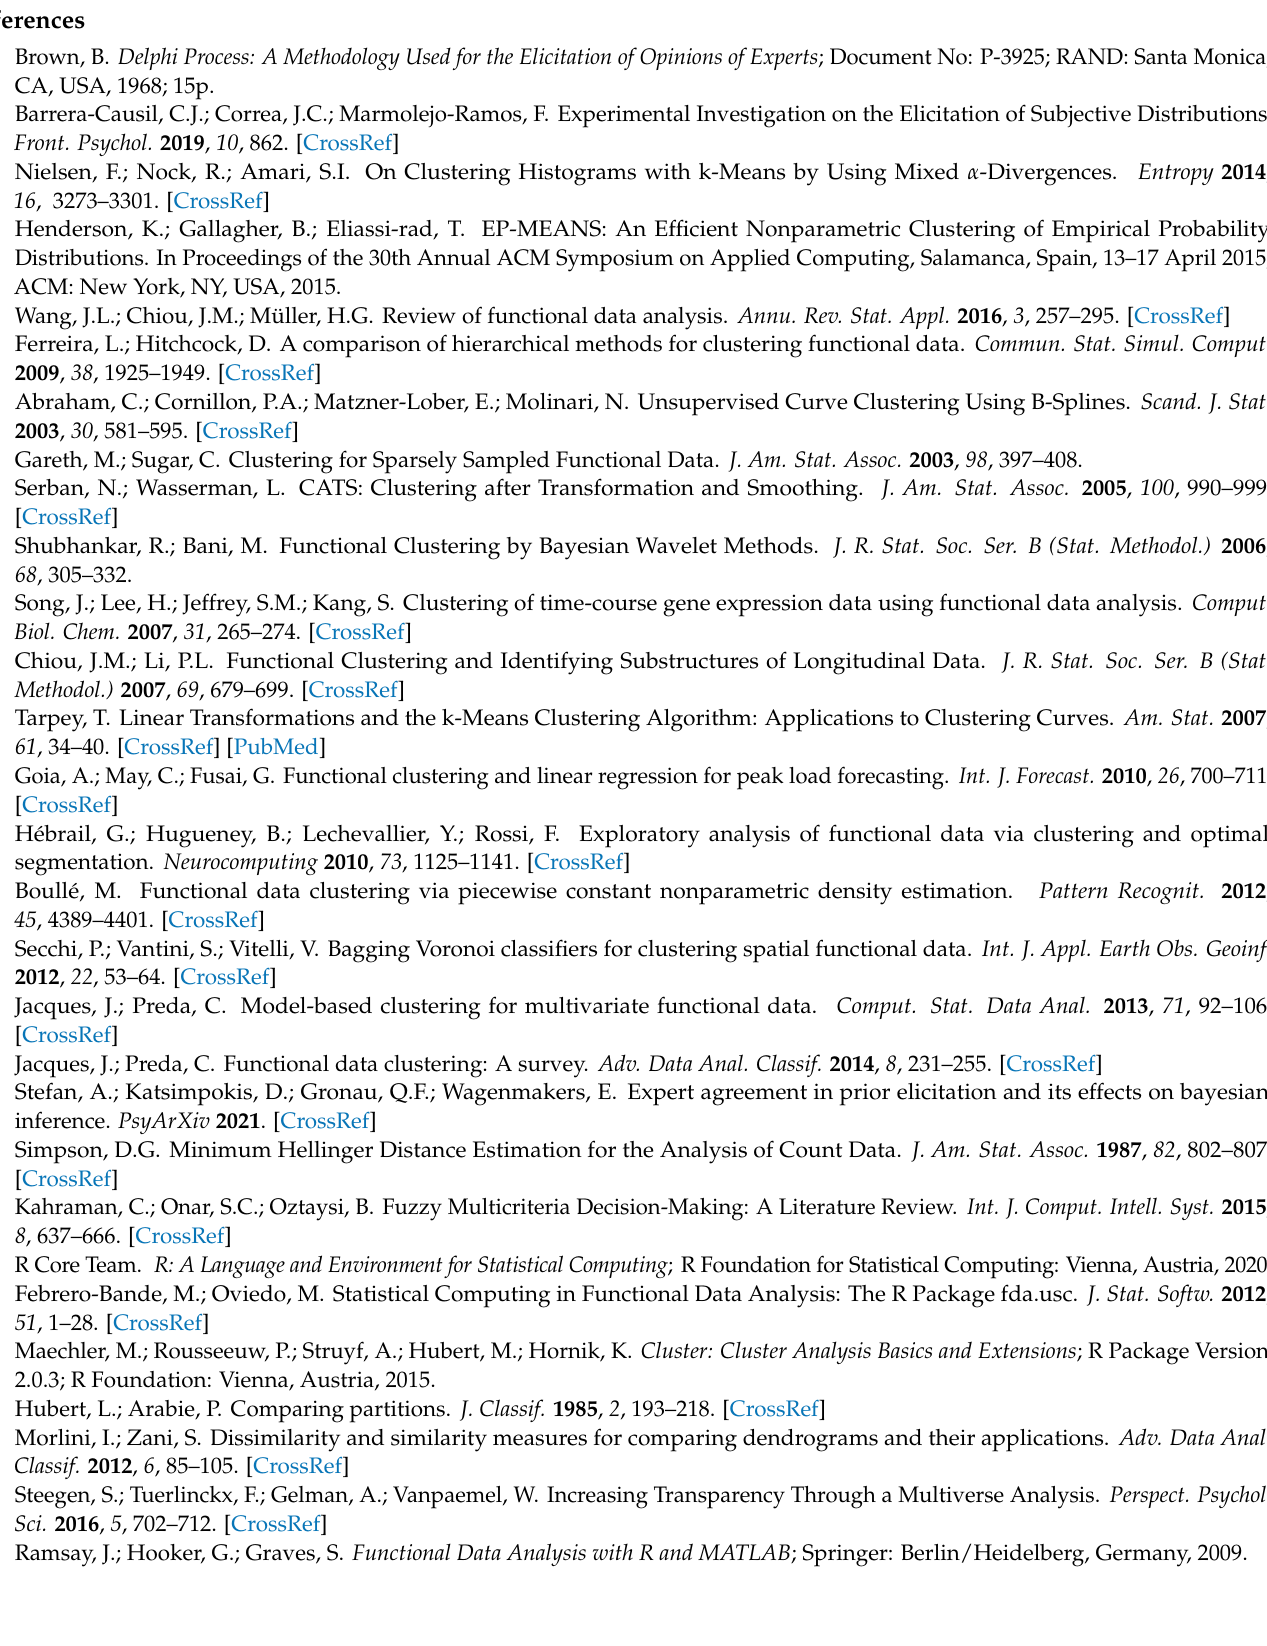
Figure A5 show that students from certain age groups have varying levels of engagement with their online program. The proposed method, thus, seems instrumental in analyzing data from online learning